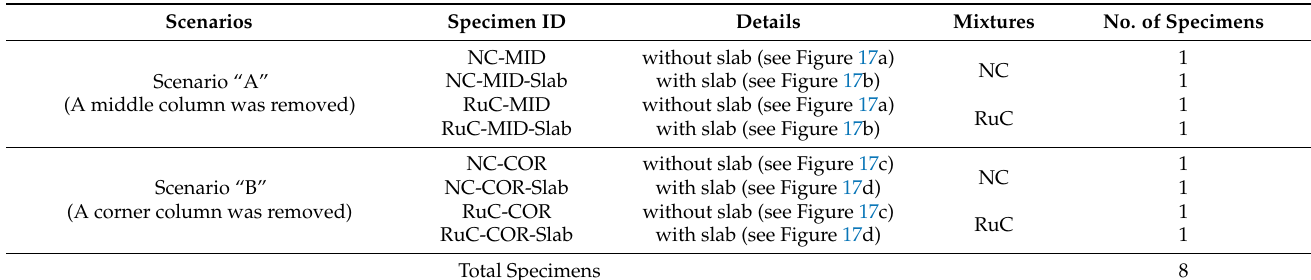
Table 9. Details of the FE analysis matrix for the 3D beam–slab